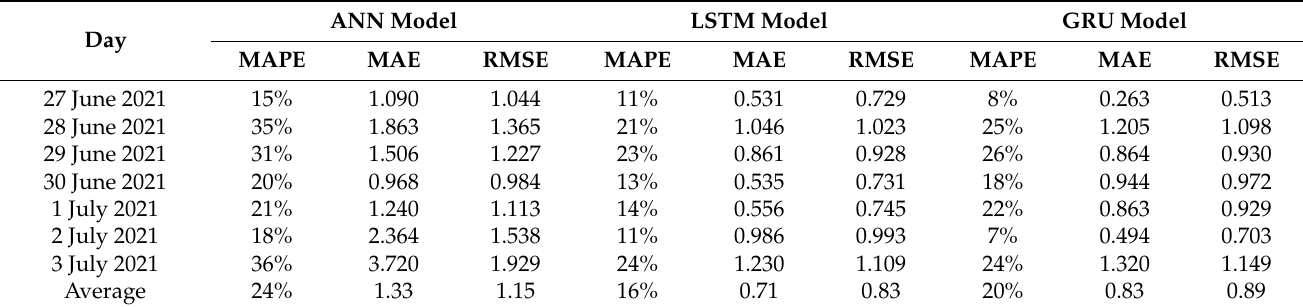
Figure 10. Comprehensive comparison results of hybrid metadata. Table 9. Daily one-day-ahead PV power forecasting results using hybrid weather parameters.